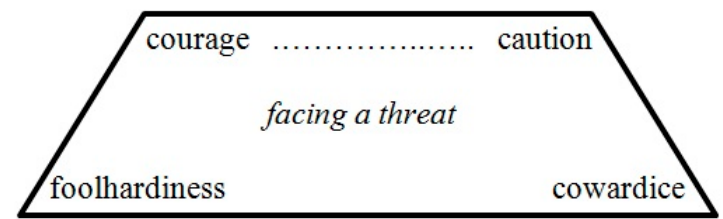
Figure 3. The Virtuous Trapezoid.